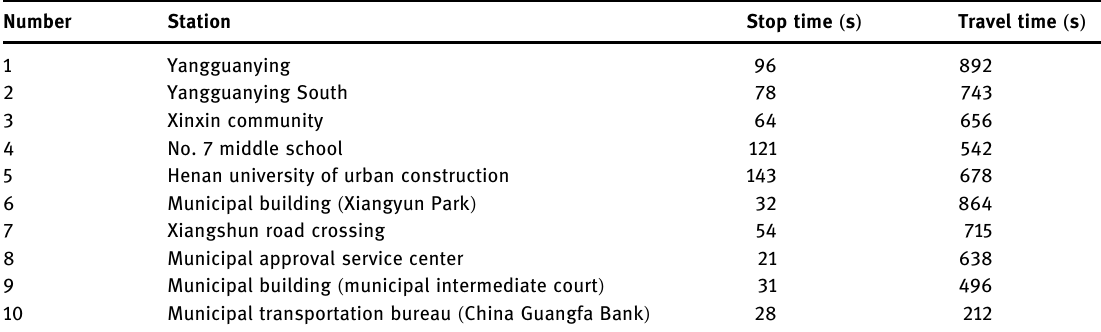
Table 3: Bus operation data on 1 day